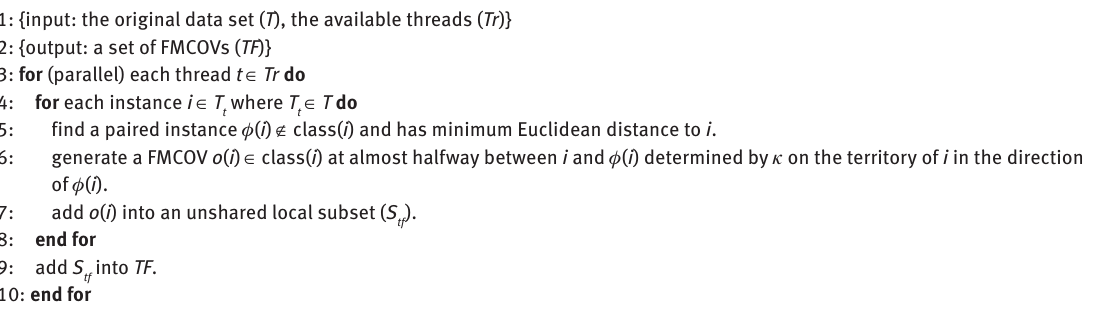
Algorithm 1: Parallel FMCOV generation algorithm.